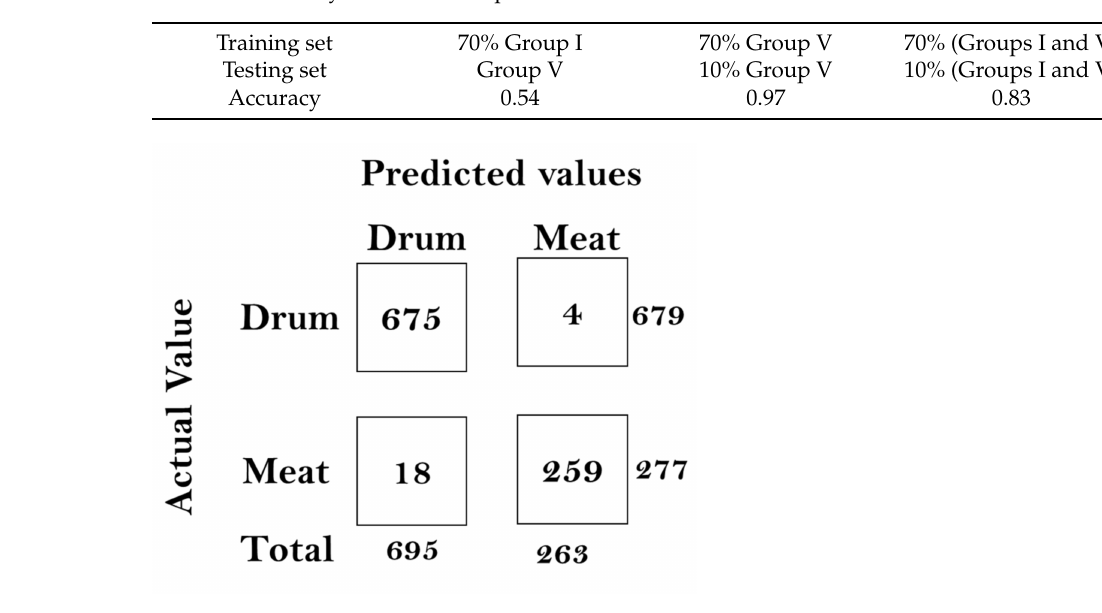
Table 12. Accuracy results of Group V.